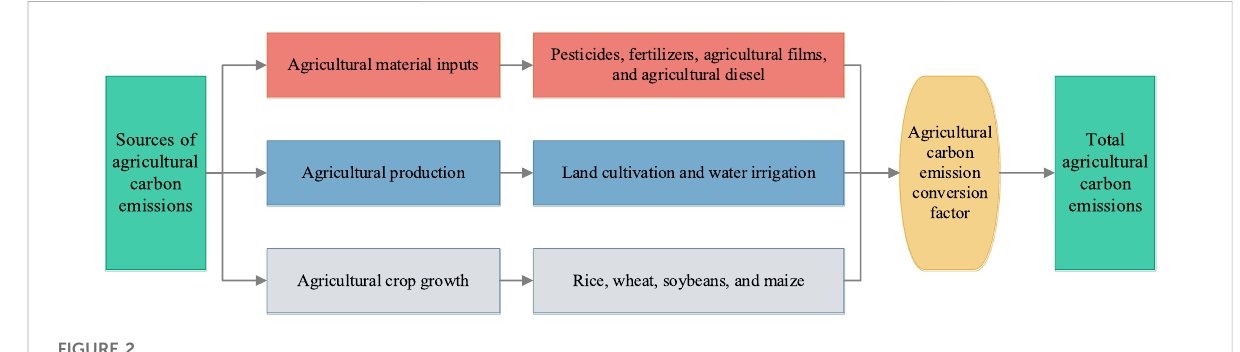
FIGURE 2 Measurement framework of agricultural carbon emissions in